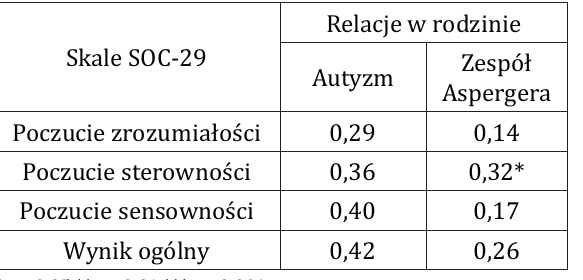
Wyniki korelacji informują o występowaniu istotnych statystycznie zależności między pozytywną oceną relacji w rodzinie a wysokim poczuciem sterowności u matek dzieci z zespołem Aspergera. 6. Ocena relacji w rodzinie a poczucie wsparcia społecznego u matek W celu określenia zależności między oceną relacji w rodzinie przez matki dzieci z autyzmem i zespołem Aspergera a poczuciem wsparcia społecznego, mierzonym Skalą Wsparcia Społecznego, autorstwa K. Kmiecik-Baran, obliczono współczynniki korelacji rho-Spearmana (tabela 6). Istotne statystycznie zależności stwierdzono między pozytywną oceną relacji w rodzinie a poczuciem wsparcia instrumentalnego u matek dzieci z zespołem Aspergera. 7.